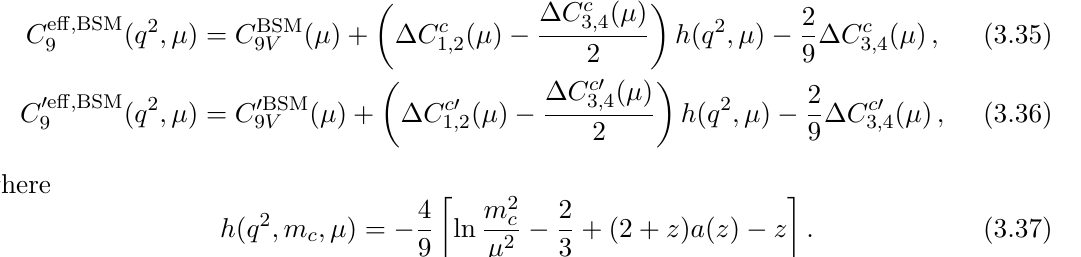
Figure 1. Leading CSBM contribution to radiative decay (left) and rare b only a constant term is present and the mixing arises at two-loop order, mirroring the situation of the